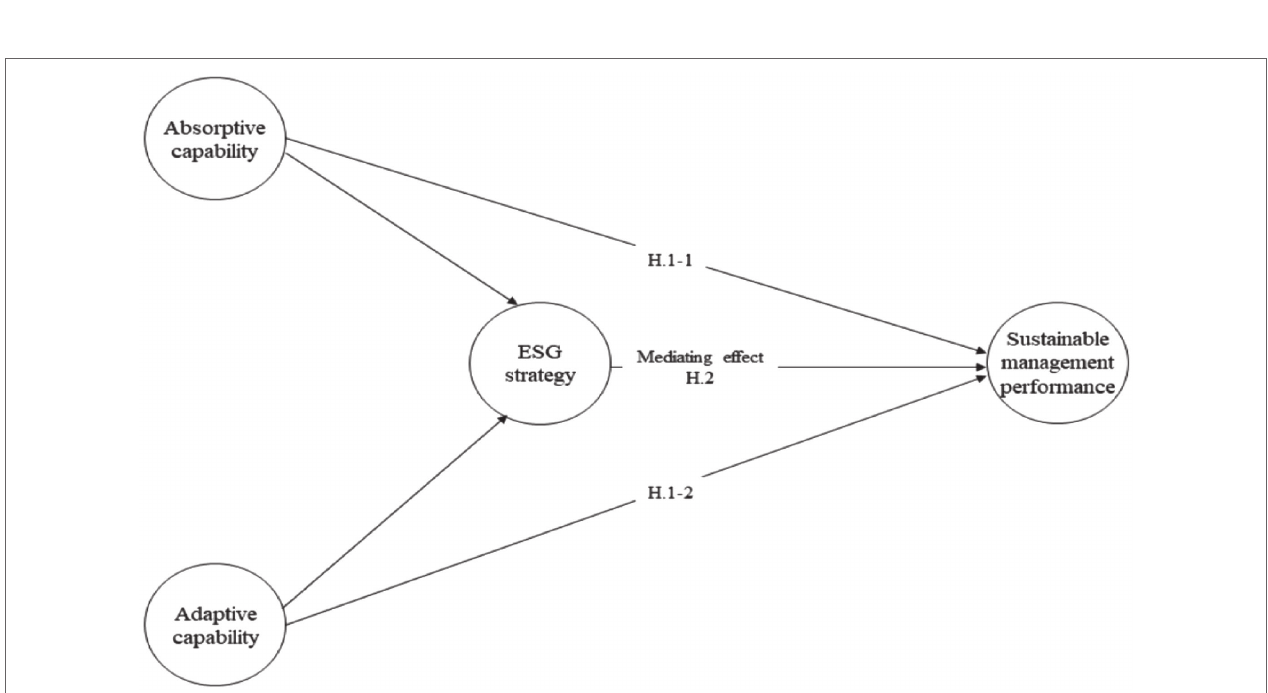
FIGURE 1 | Research